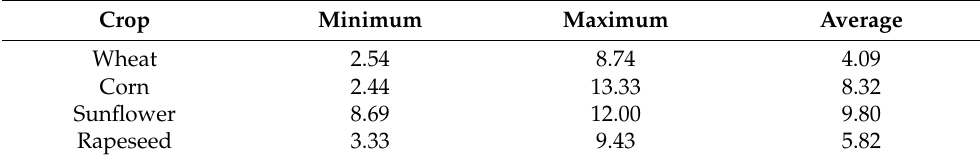
Table 4. Minimum, maximum, and average increases in water-use productivity (%).